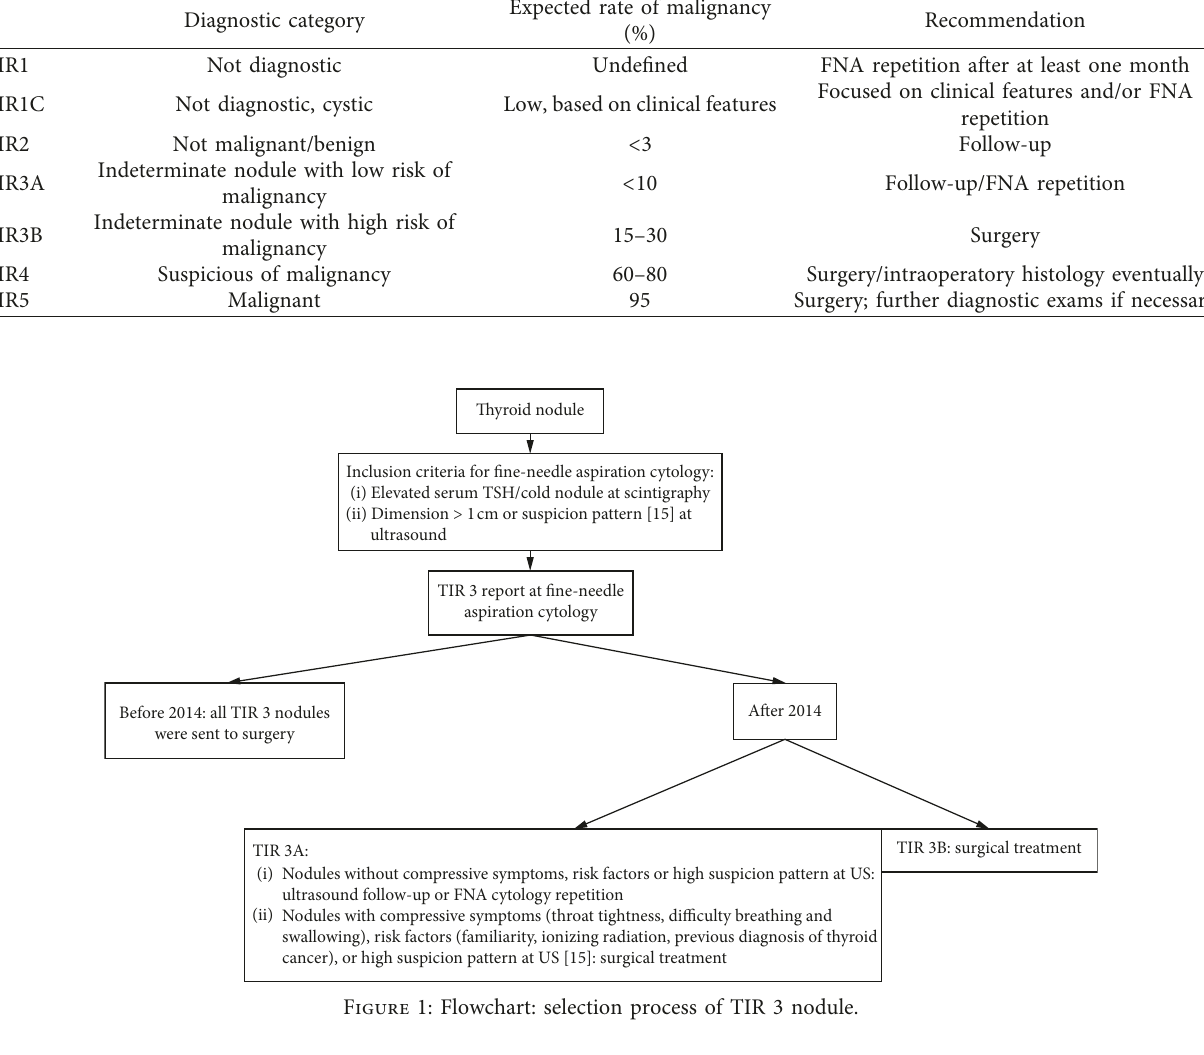
Table 1: Diagnostic categories, expected risk of malignancy, and suggested management in 2014 ICCRTC classification [14].